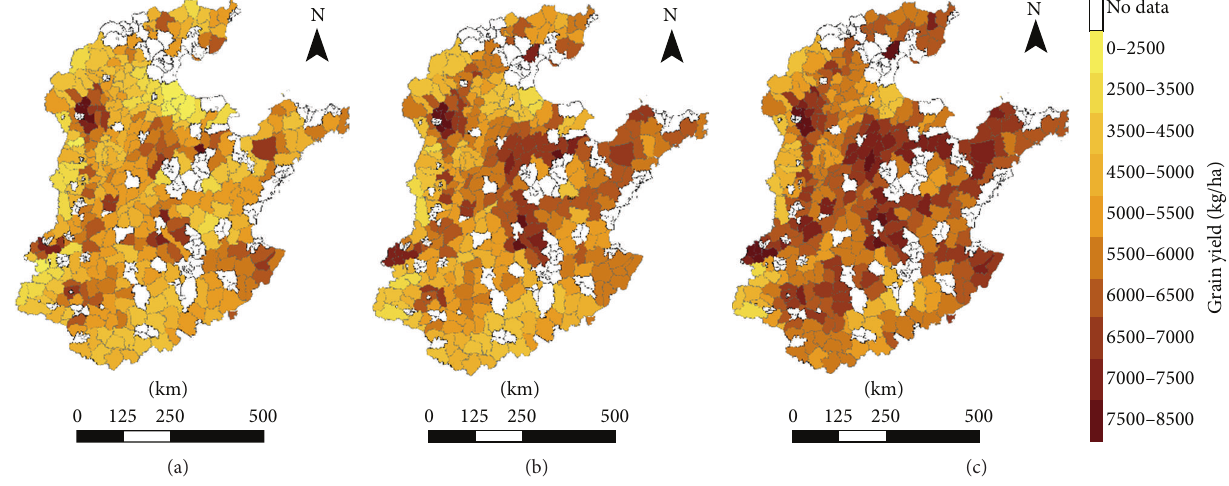
Figure 3: County-level grain yield of the North China Plain, (a) 2000, (b) 2005, and (c) 2008.